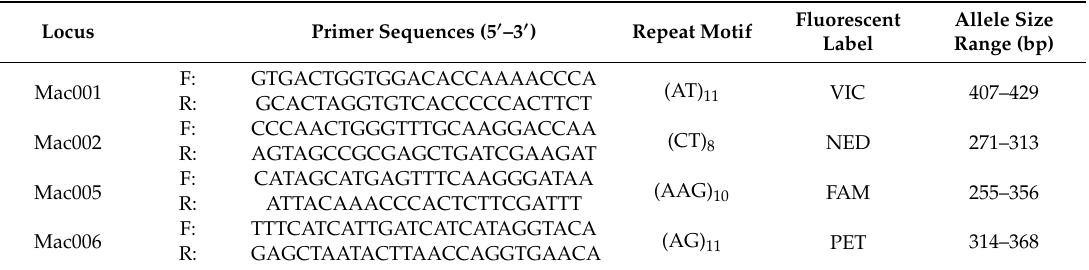
Table 6. Polymorphic microsatellite loci used to determine paternity of macadamia kernels 1 . Locus Primer Sequences (5 (cid:48) –3 (cid:48) ) Repeat